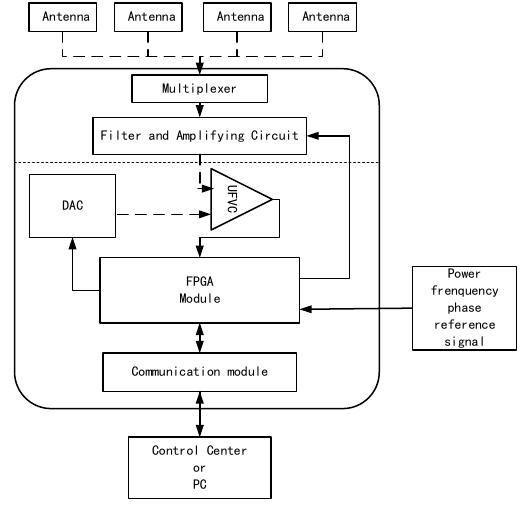
Figure 2. The configuration of the intelligent sensor.